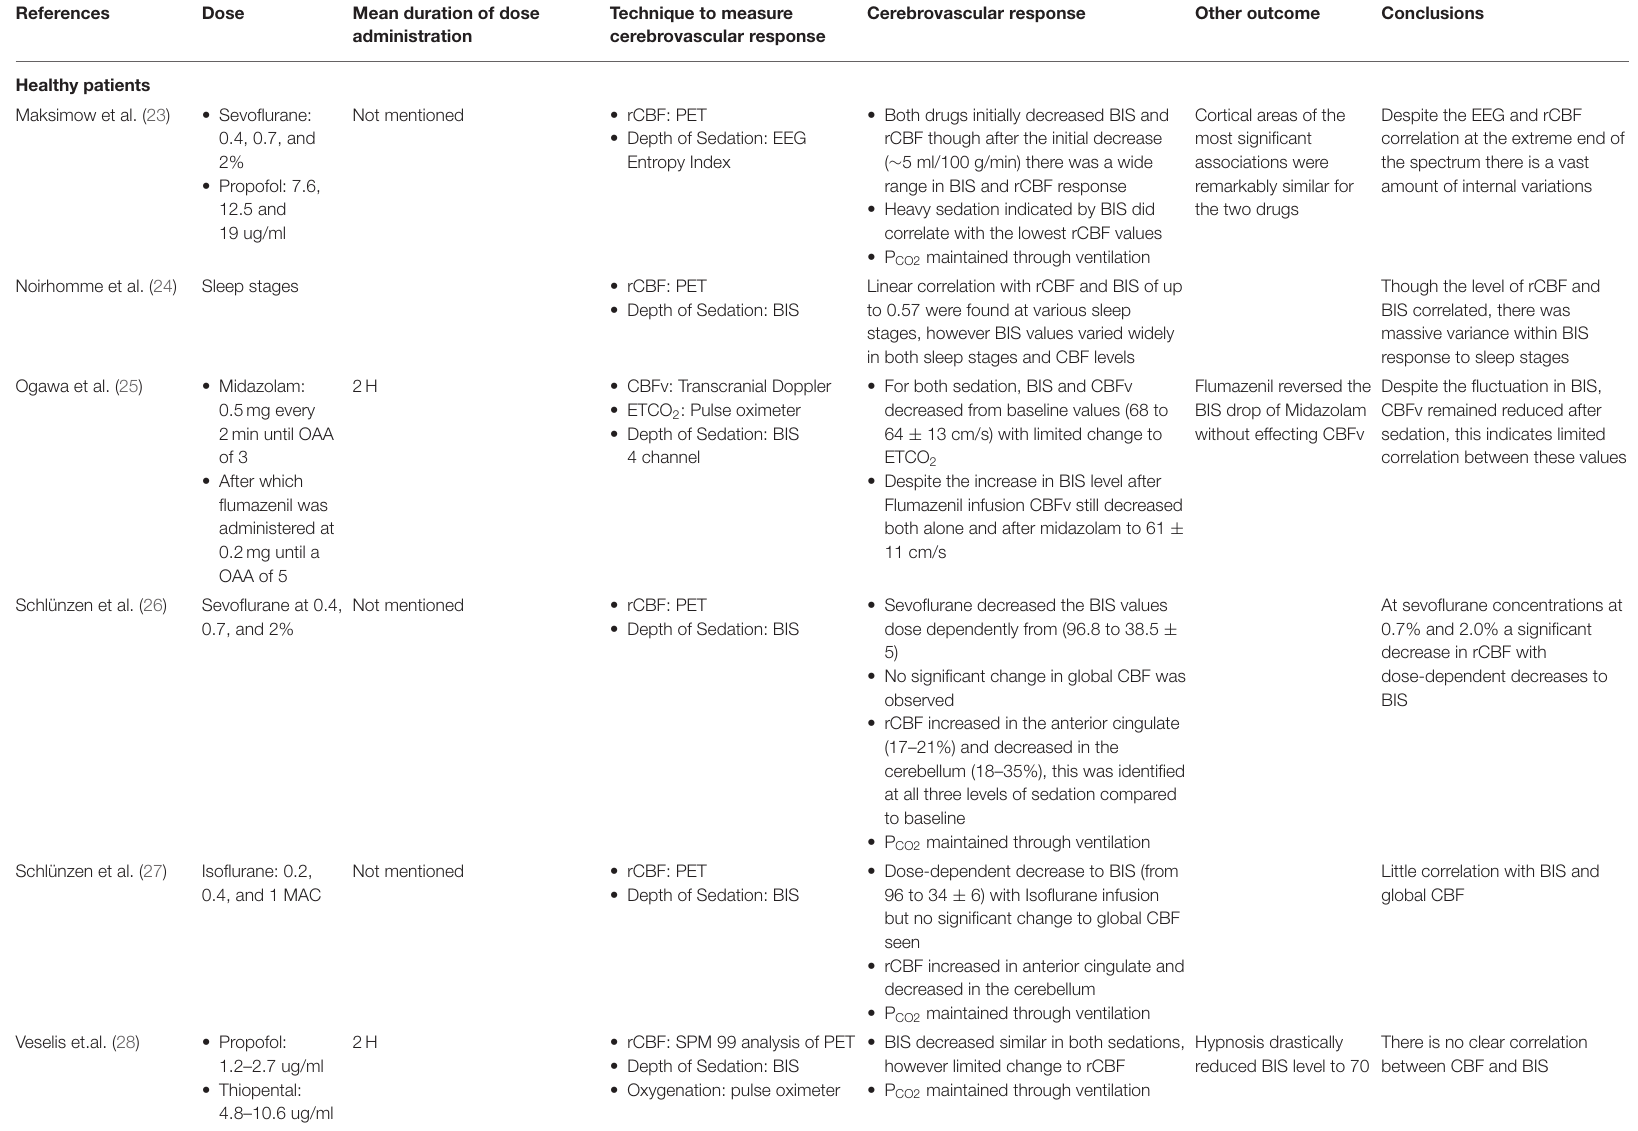
TABLE 2 | Human treatment and cerebrovascular response–study